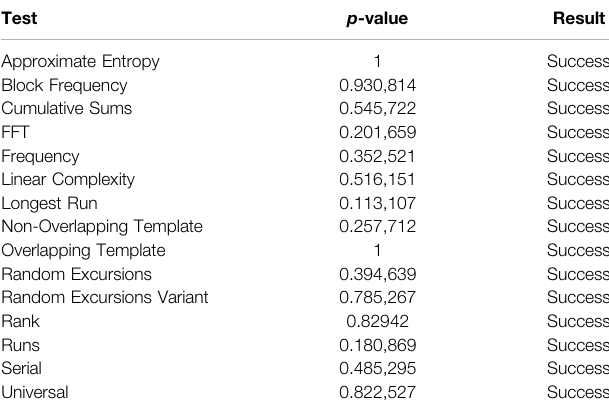
TABLE 4 | Results of SP 800 – 22 test using x 3 after decorrelation operation.